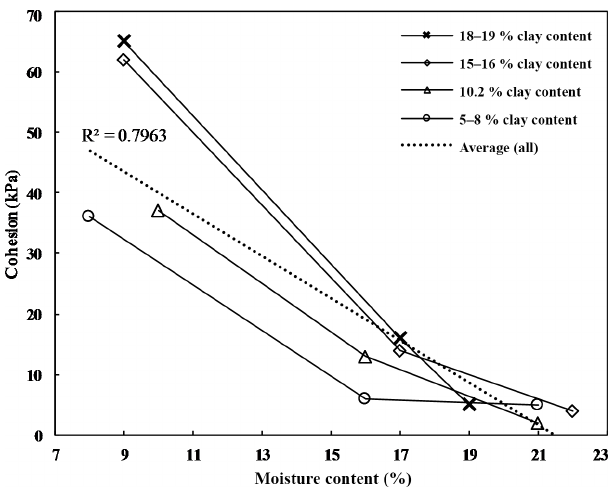
Figure 4. Cohesion of loess at varying moisture contents, when loess clay content is